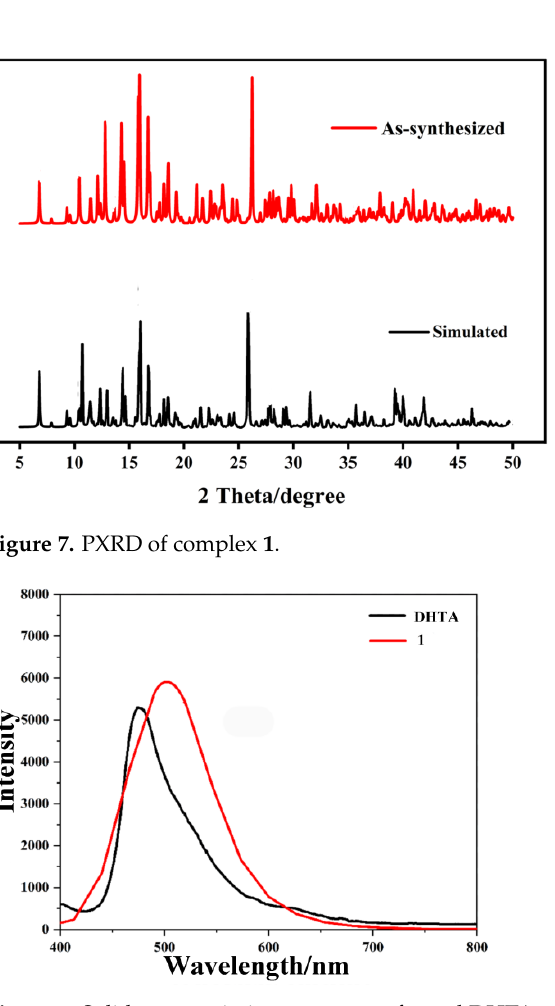
Figure 8. Solid-state emission spectrum of 1 and DHTA at room temperature.